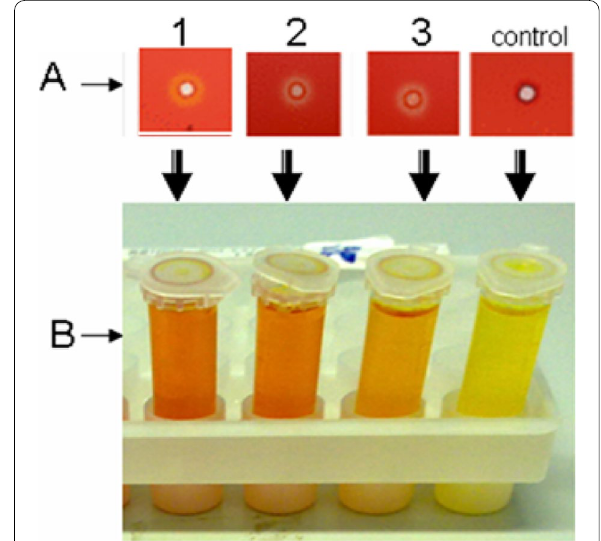
Fig. 1 Activity screening for isolated recombinant cellulase clones (1, 2 and 3) derived from soil metagenomic. A Well cut method and B DNS method against negative control